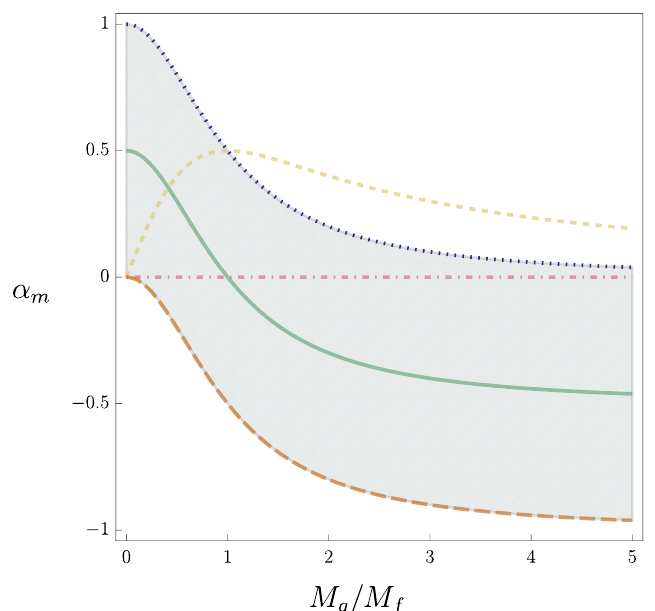
Figure 2 . A plot of the allowed parameter space for the coupling constant (cid:11) m = (cid:20) m M the ratio M g =M f . The shaded region corresponds to the allowed parameter space. The di(cid:11)erent curves correspond to di(cid:11)erent matter couplings: coupling to the g metric only (blue, dotted), to the f metric only (orange, long dash), equally to both metrics (green, solid), to the massless eigenstate only (pink, dot dashed), and equal coupling to both the massive and massless eigenstates (yellow, short dash). The information contained in this plot is equivalent to that in (cid:12)gure 1, but